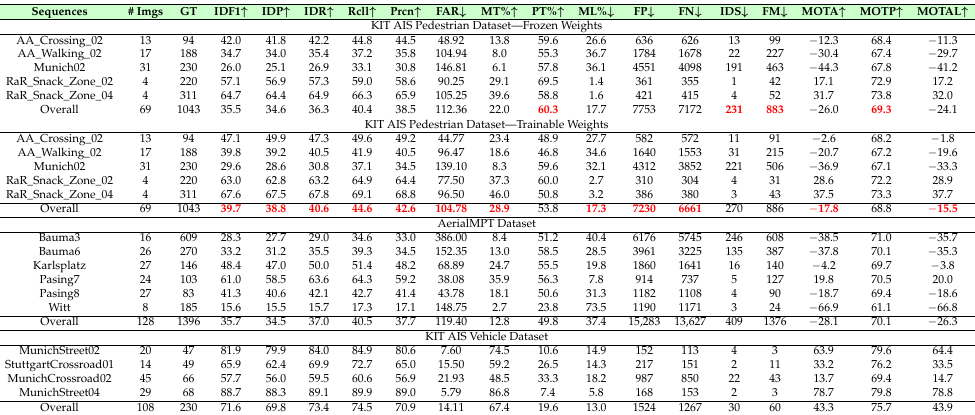
Table 11. AerialMPTNet LSTM on the KIT AIS and AerialMPT datasets. The best overall values of the two configurations on the KIT AIS pedestrian dataset are highlighted. Sequences